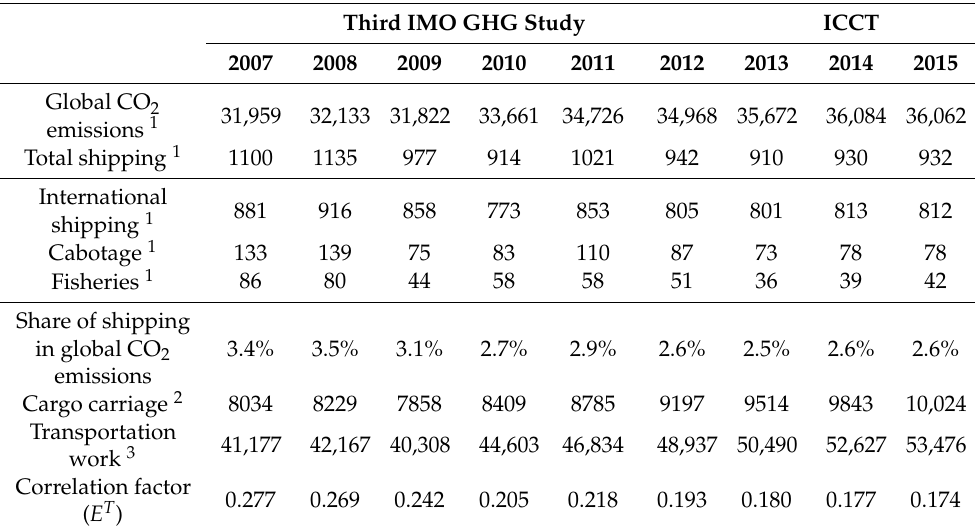
Table 2. Worldwide CO 2 emissions from international shipping as a total of global anthropogenic emissions, cargo carriage volume and transportation work performed,